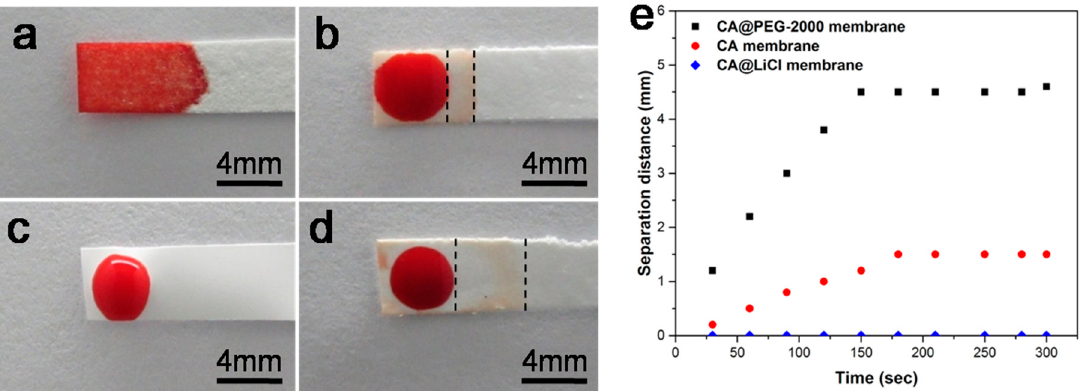
Figure 4. The diffusion distances of whole blood samples in ( a ) a paper strip, ( b ) CA membranes, ( c ) CA@LiCl membranes, and ( d ) CA@PEG-2000 membranes, ( e ) The diffusion distances-time rela- tionship of whole blood samples in CA membranes, CA@LiCl membranes, and CA@PEG-2000